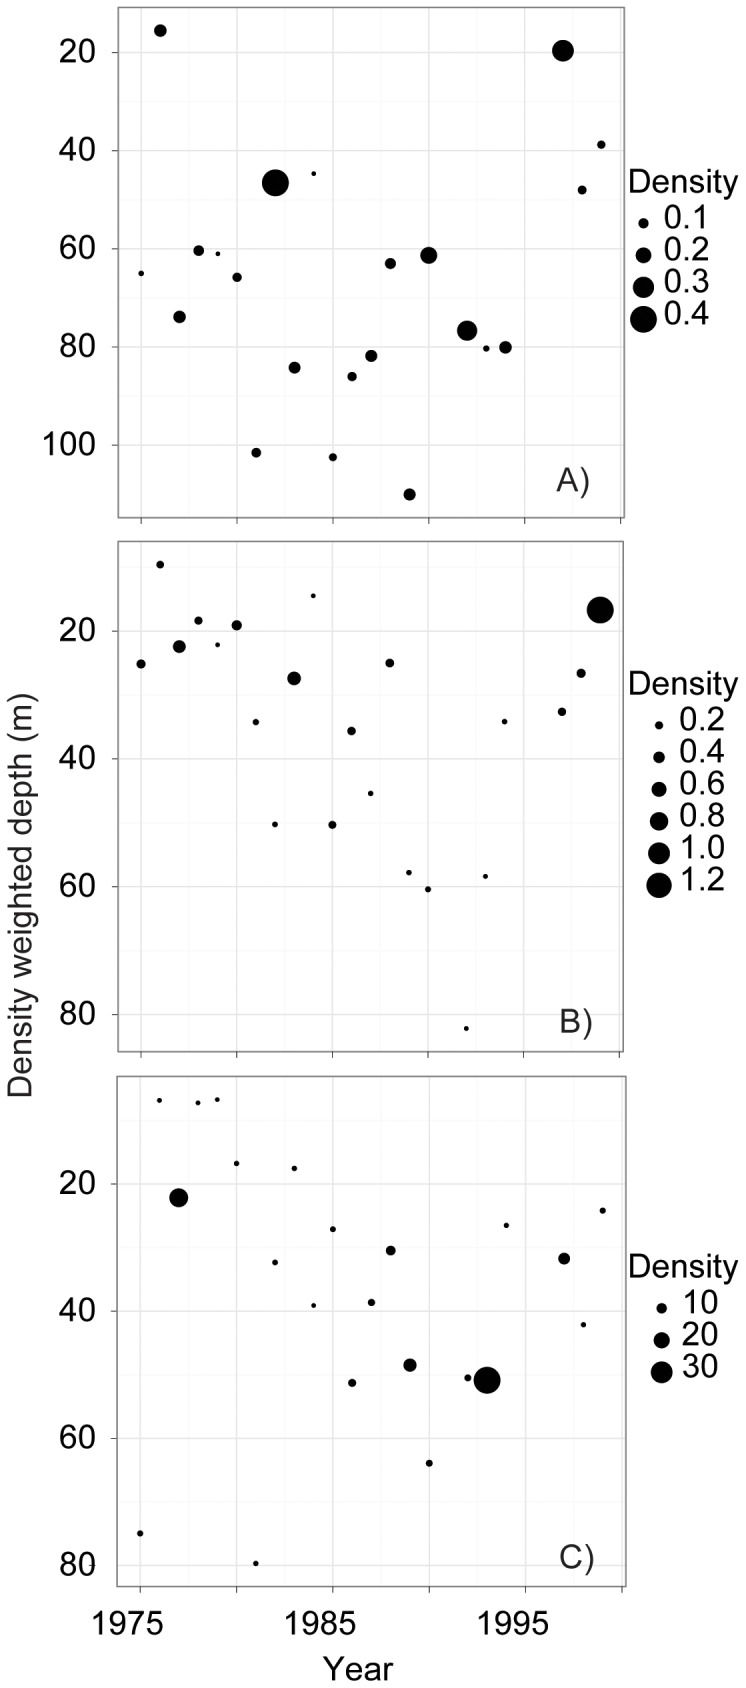
Abundance and density-weighted average summer depth of phytoplankton groups.Panels: A = Dinoflagellates; B = Green Algae; C = Unidentified Picoplankton (1000 cells l−1). Unidentified Picoplankton are unidentified cells at the limits of detection using standard methods in light microscopy, approximately 1–2 µm. Bubble size indicates average abundance (1000 cells l−1).